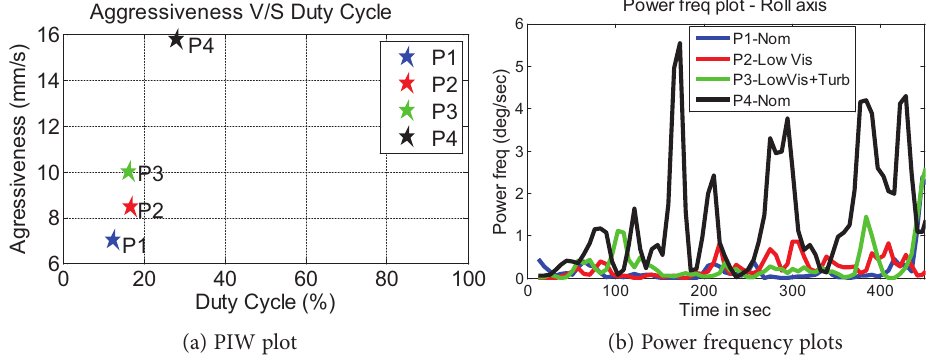
(b) Power frequency plots